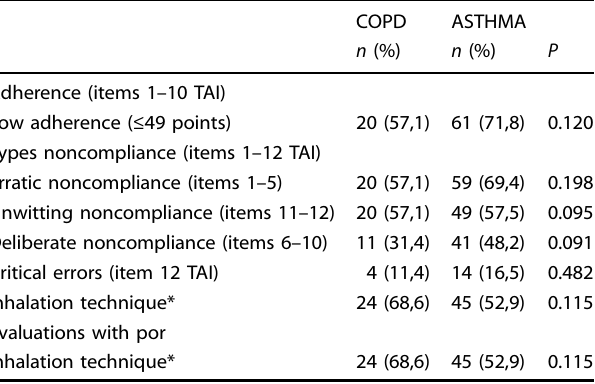
Table 4. Changes in adherence, type of noncompliance, and critical errors between COPD and